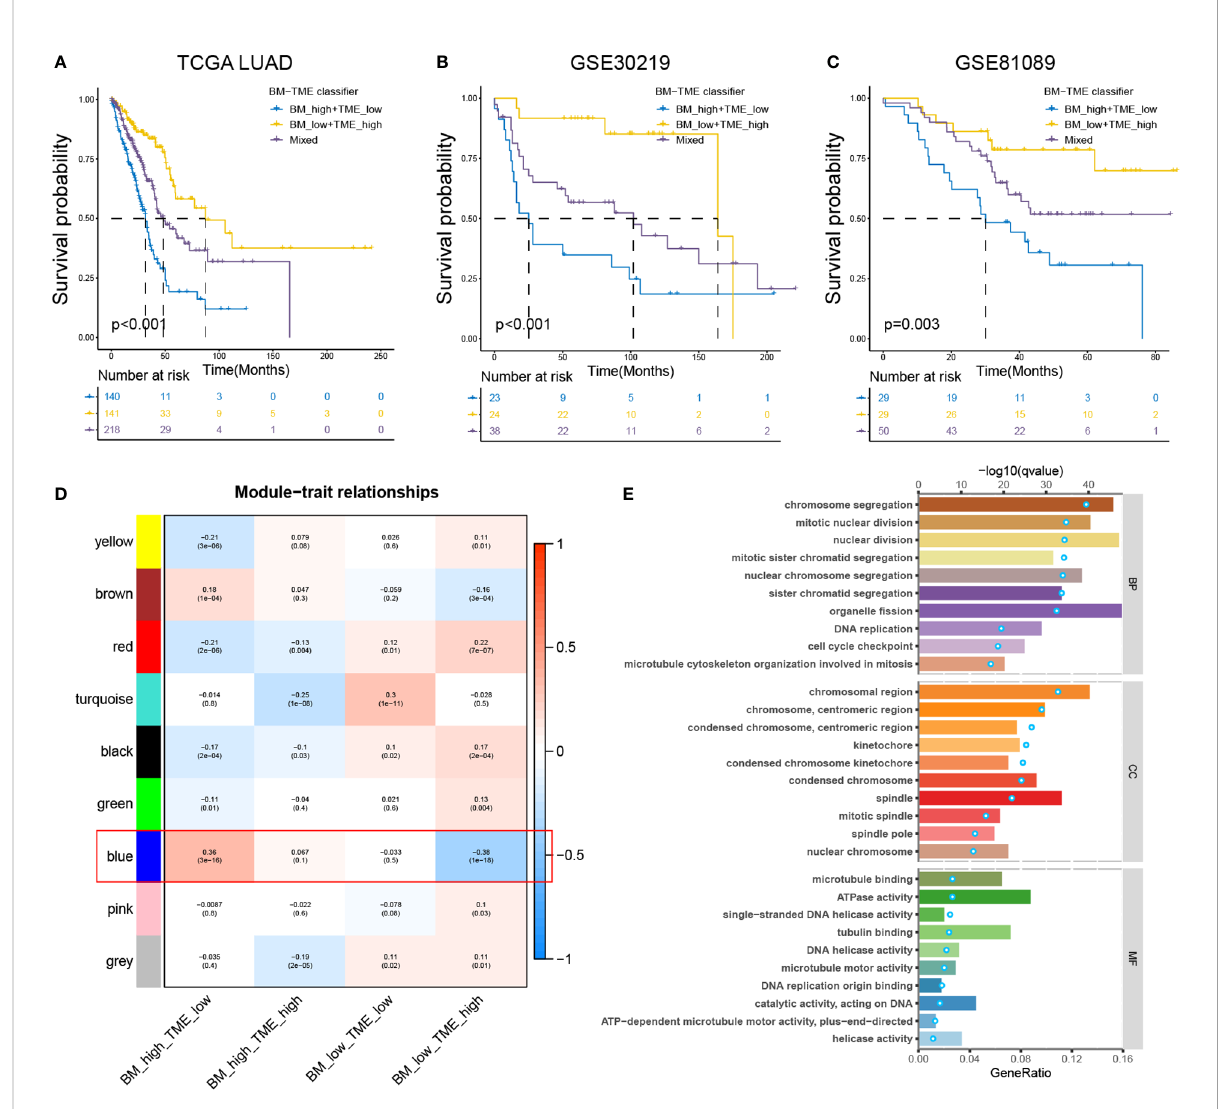
FIGURE 4 Prognostic value and enrichment analysis relevant to BM-TME classi fi er. (A – C) Kaplan – Meier overall survival curves of the training set (TCGA- LUAD cohort) and validation sets (GSE30219 and GSE81089 cohort) based on BM-TME classi fi er. (D) Heat map depicting the correlation between various gene modules of WGCNA analysis and BM-TME subgroups. (E) Top ten biological process (BP), cellular component (CC) and molecular function (MF) enrichment pathways based on GO analysis of blue module genes. Bar plots correspond to the lower axis; dot plots correspond to the upper